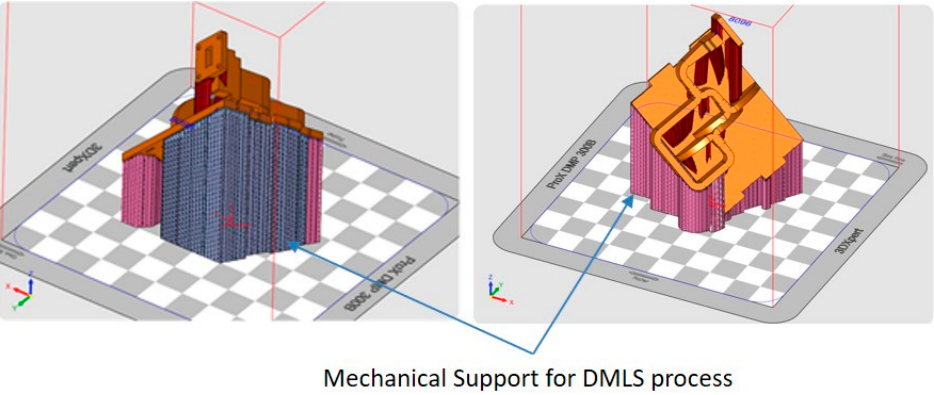
Figure 12. Orientation of the SWA array in the printing chamber and placement of the support structures.